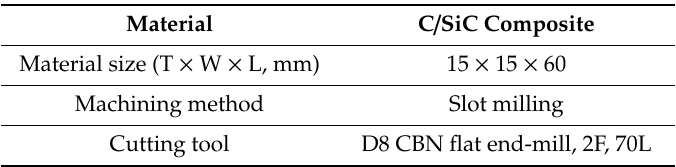
Table 3. The machining